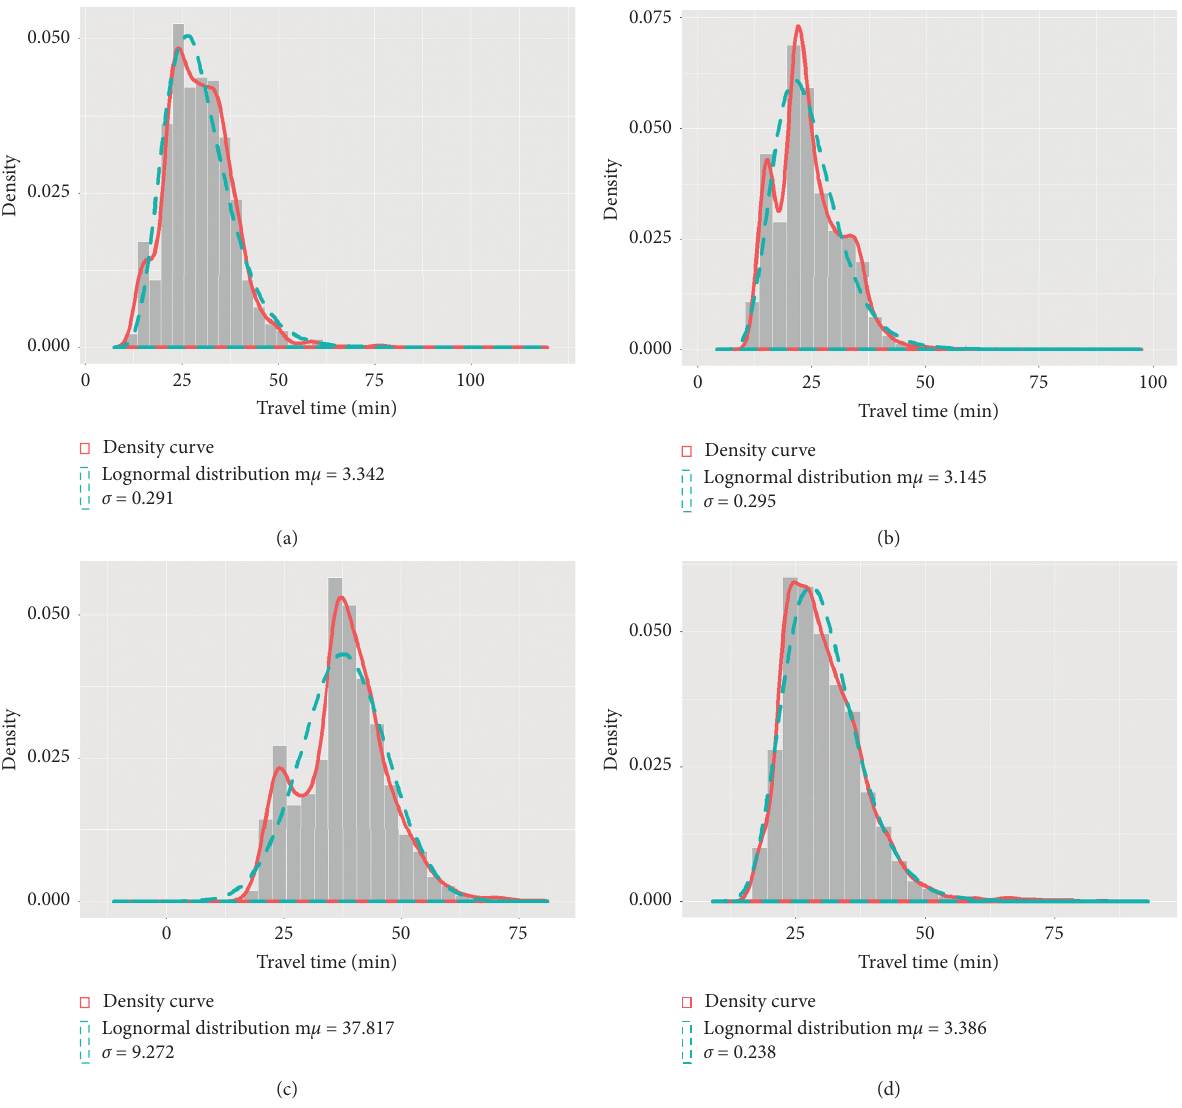
Figure 5: Selected distributions for the observed travel time data during different time periods. (a) Peak hours of elevated expressway, (b) off-peak hours of elevated expressway, (c) peak hours of urban arterial road, and (d) off-peak hours of urban arterial road.